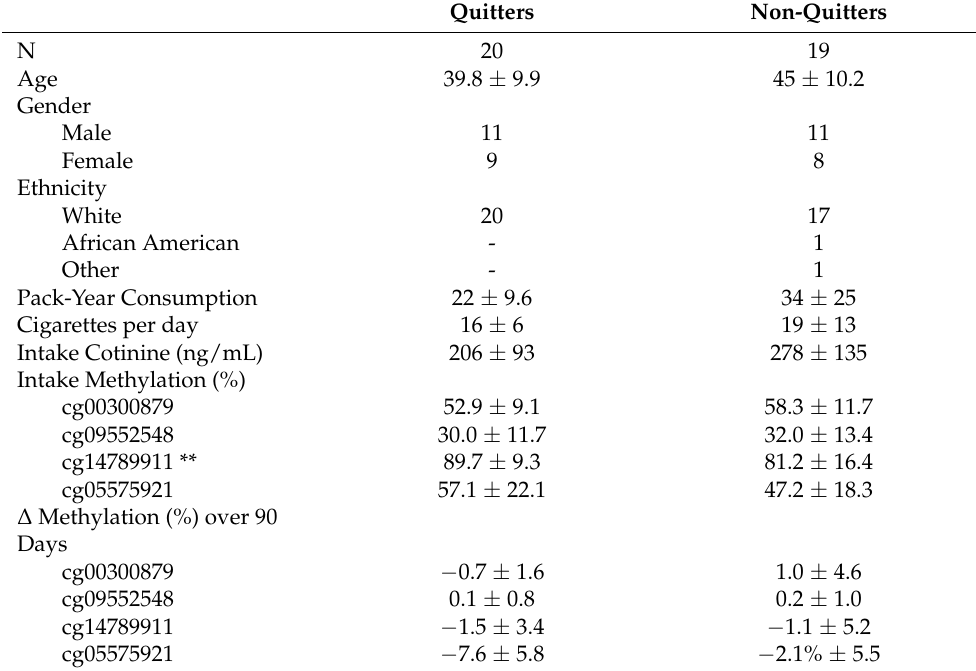
Table 1. Demographic and clinical characteristics of the subjects. Quitters